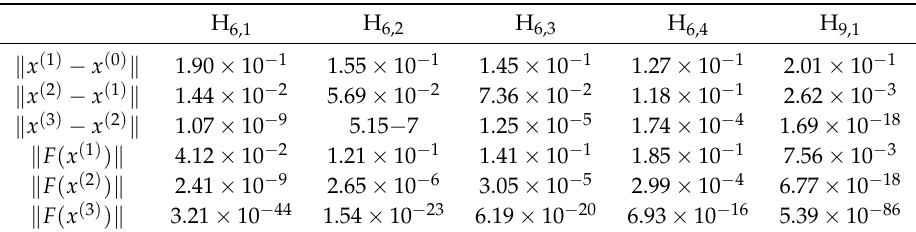
Table 4. Numerical results for Example